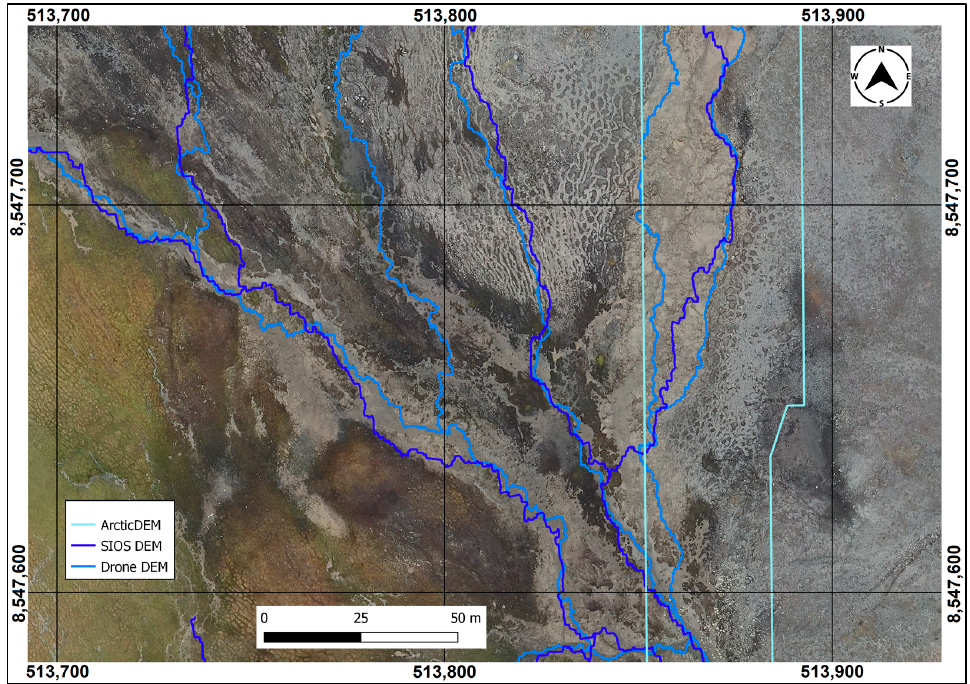
Figure 10. Comparison of stream delineations using different DEMs in Fuglebekken.